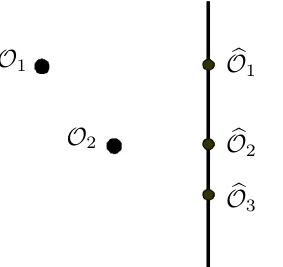
Figure 1 . In the presence of a defect, one can consider correlators of local and defect operators. Because the defect breaks the conformal algebra down to a subalgebra, even low-point functions can acquire non-trivial coordinate dependence. In this work we will concentrate exclusively on defect excitations (hatted operators in the (cid:12)gure) which de(cid:12)ne a lower dimensional CFT. block expansion with positive coe(cid:14)cients and they satisfy a crossing symmetry